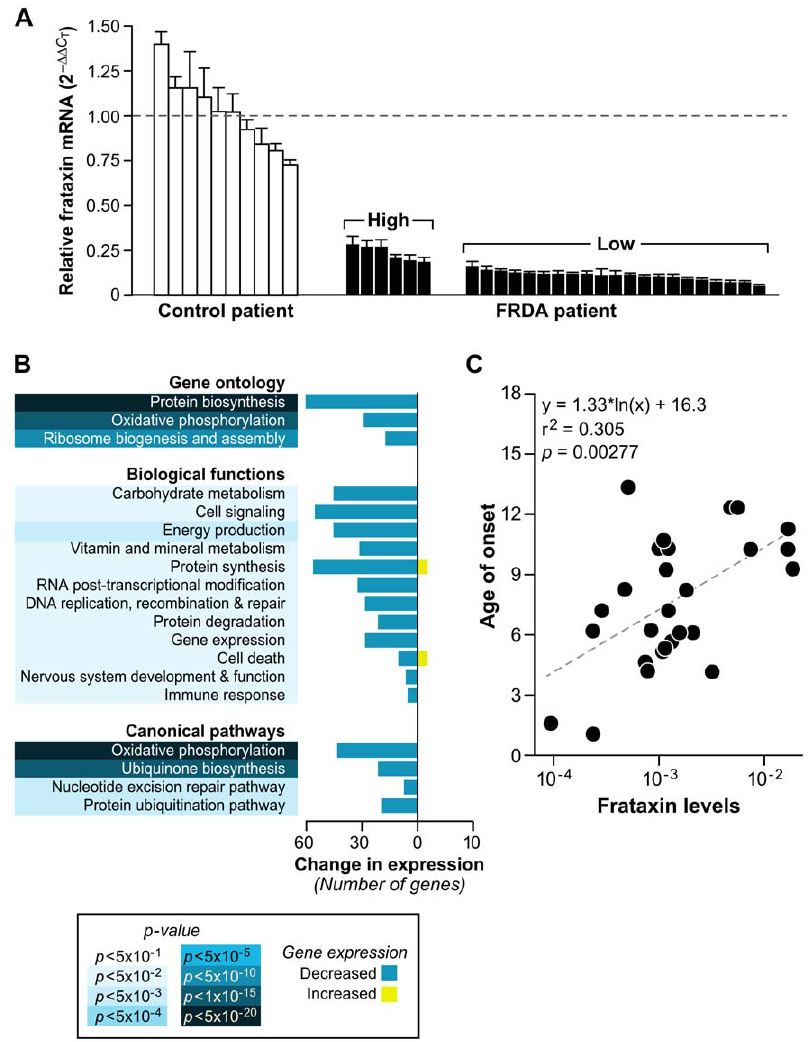
Figure 4. Patients with lower levels of frataxin correlate with age of onset of disease and have more compromised mitochondrial and protein biosynthetic function. (A) Real-time PCR of frataxin levels in all patients with available RNA (27) were compared to controls (10). Levels of frataxin are relative to the average D C T of the controls (dotted line). The error bars represent standard deviations. Brackets encompass the patients stratified by their expression distribution into those expressing higher levels of frataxin (n=6) and those expressing lower levels of frataxin (n=21) (see Figure S1). (B) Global gene expression changes were analyzed in the patients with low levels of frataxin vs. patients with high levels of frataxin. Significantly differentially expressed genes (SAM FDR # 8%; p # 0.05; n=973) were further examined for gene ontology groups categorized by biological process. The same list of genes was analyzed with IPA (Ingenuity Systems), which identified significant biological functions and canonical pathways. All gene groups contain mostly downregulated genes, indicating compromised mitochondrial and biosynthetic function in patients with the lowest expression of frataxin. (C) Age of onset plotted against the Real-time PCR frataxin levels yields a correlation of r 2 =0.305 ( p =0.00277).